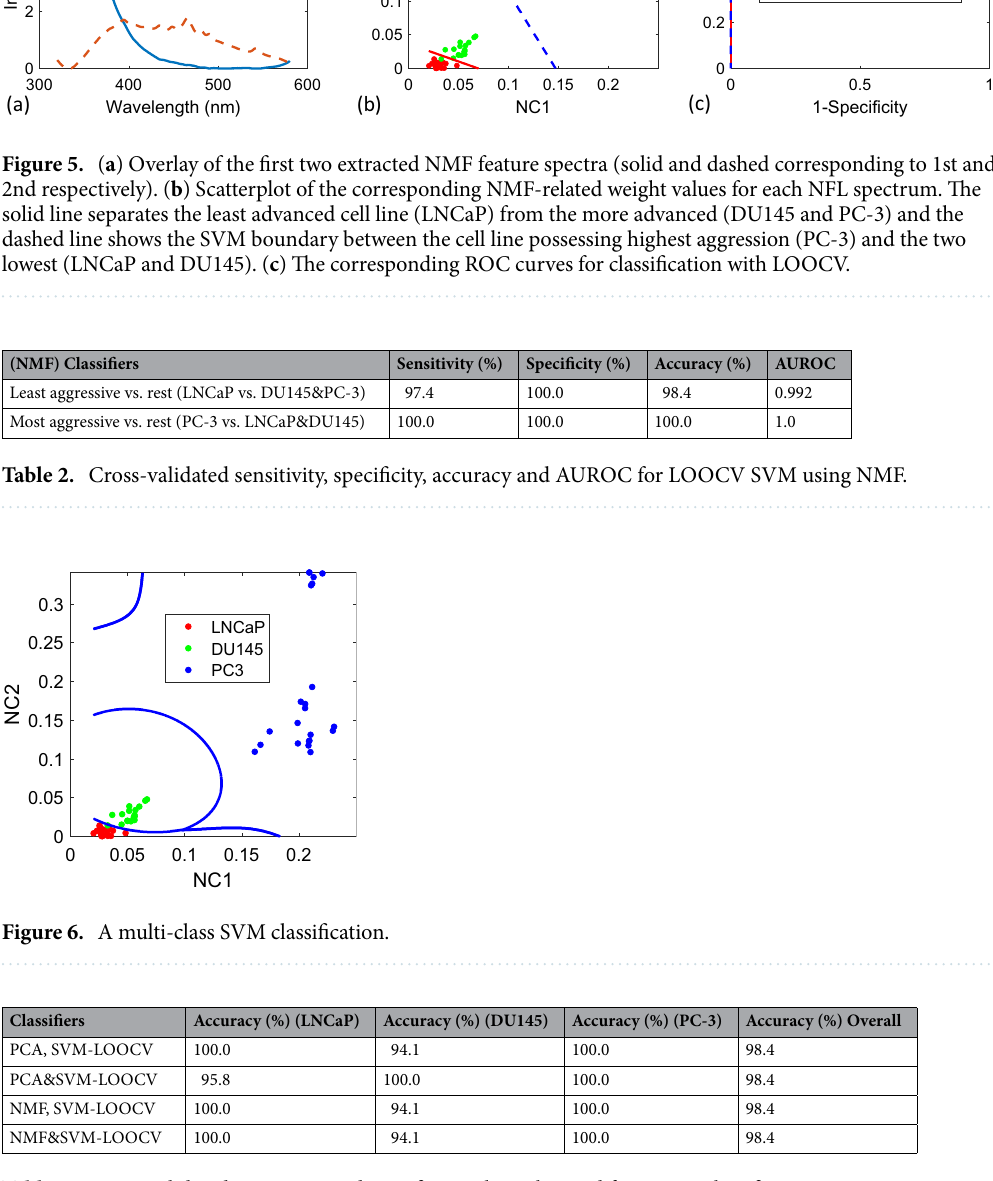
Table 3. Cross-validated sensitivity and specificity values obtained from NFL classification using